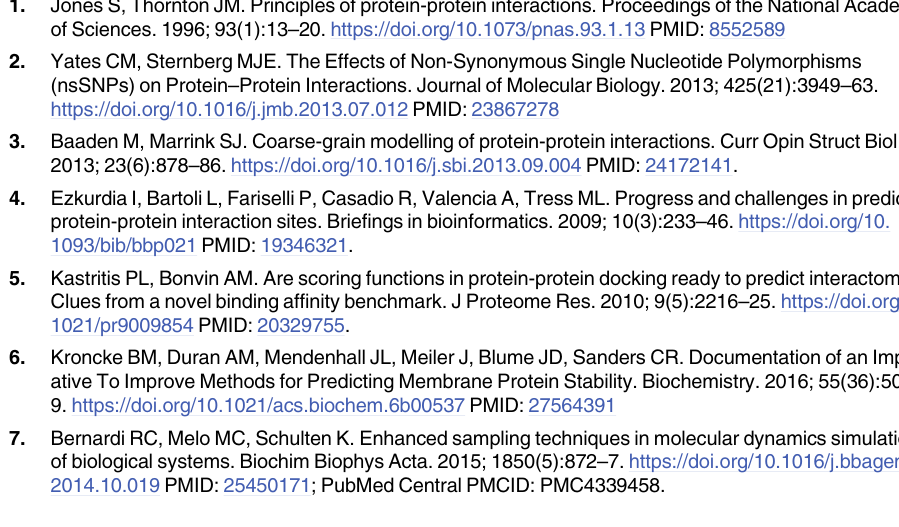
S4 Fig. Performance of each evaluated method for Ab and non-Ab complexes in predicting true ΔΔ G values ( ρ ), linearly correlated ΔΔ G values ( r ), and rank order ( ρ and τ ) for a c select subset of mutations with wild type amino acids that are neither glycine nor proline. The error for each method is reported under the correlation